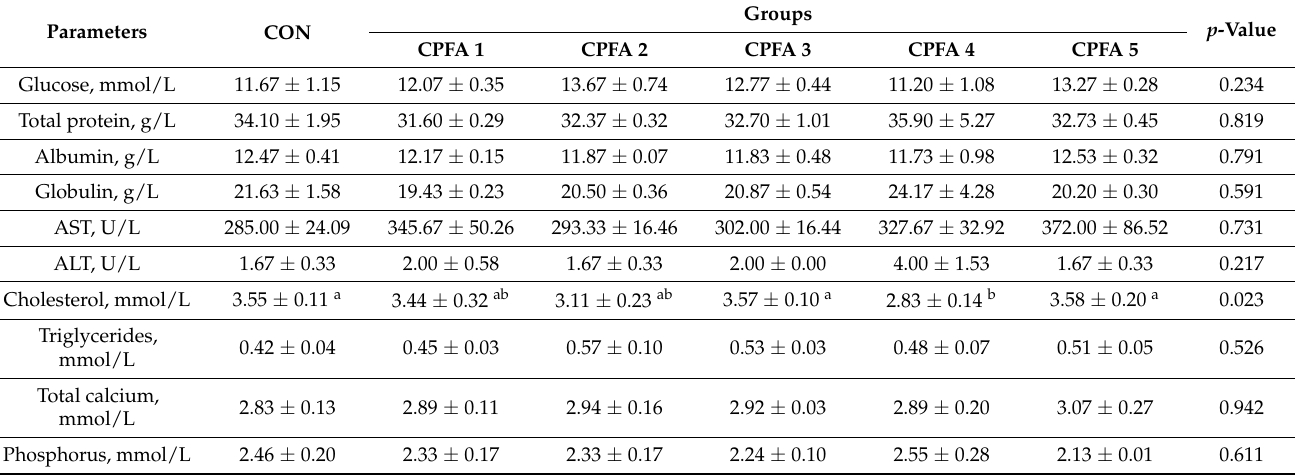
Table 8. Biochemical parameters of Ross 308 cross broiler